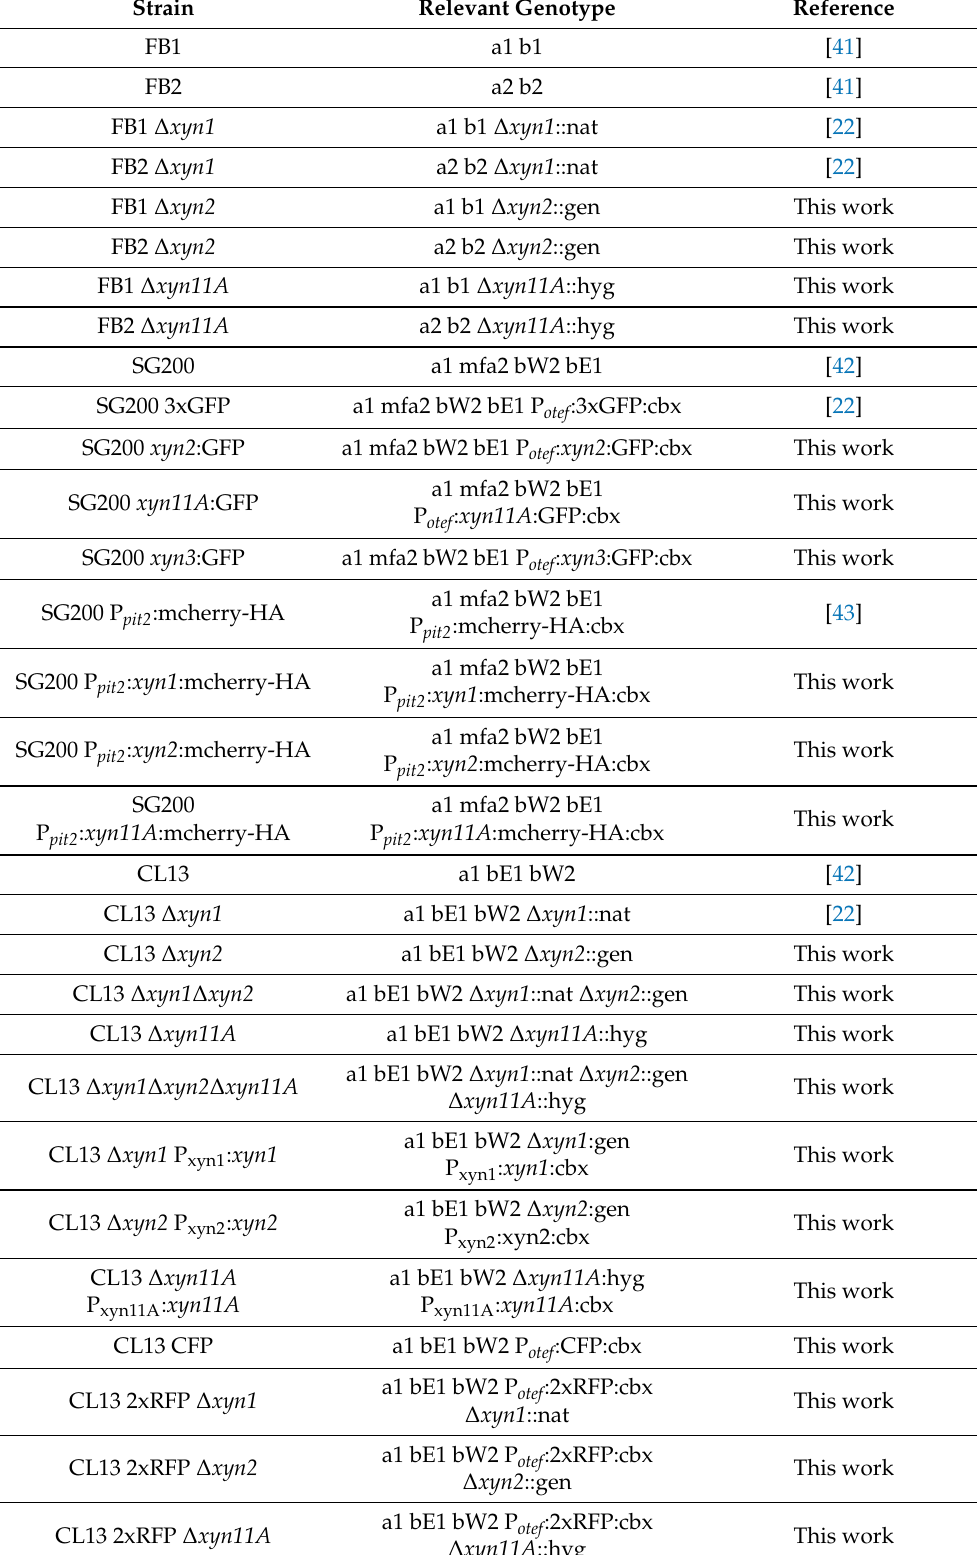
Table 1. Strains used in this